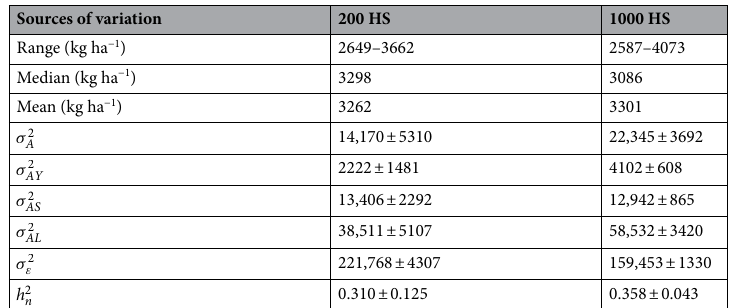
Table 1. Ranges, medians, means (based on BLUP estimates), variance components and associated standard error (± SE) and family mean narrow sense heritability for herbage DM yield estimated from the 200 and 1000 HS family data; evaluated across two sites over 2 years and 3 seasons per year. The estimated variance components were used as starting points for simulation of breeding methods.